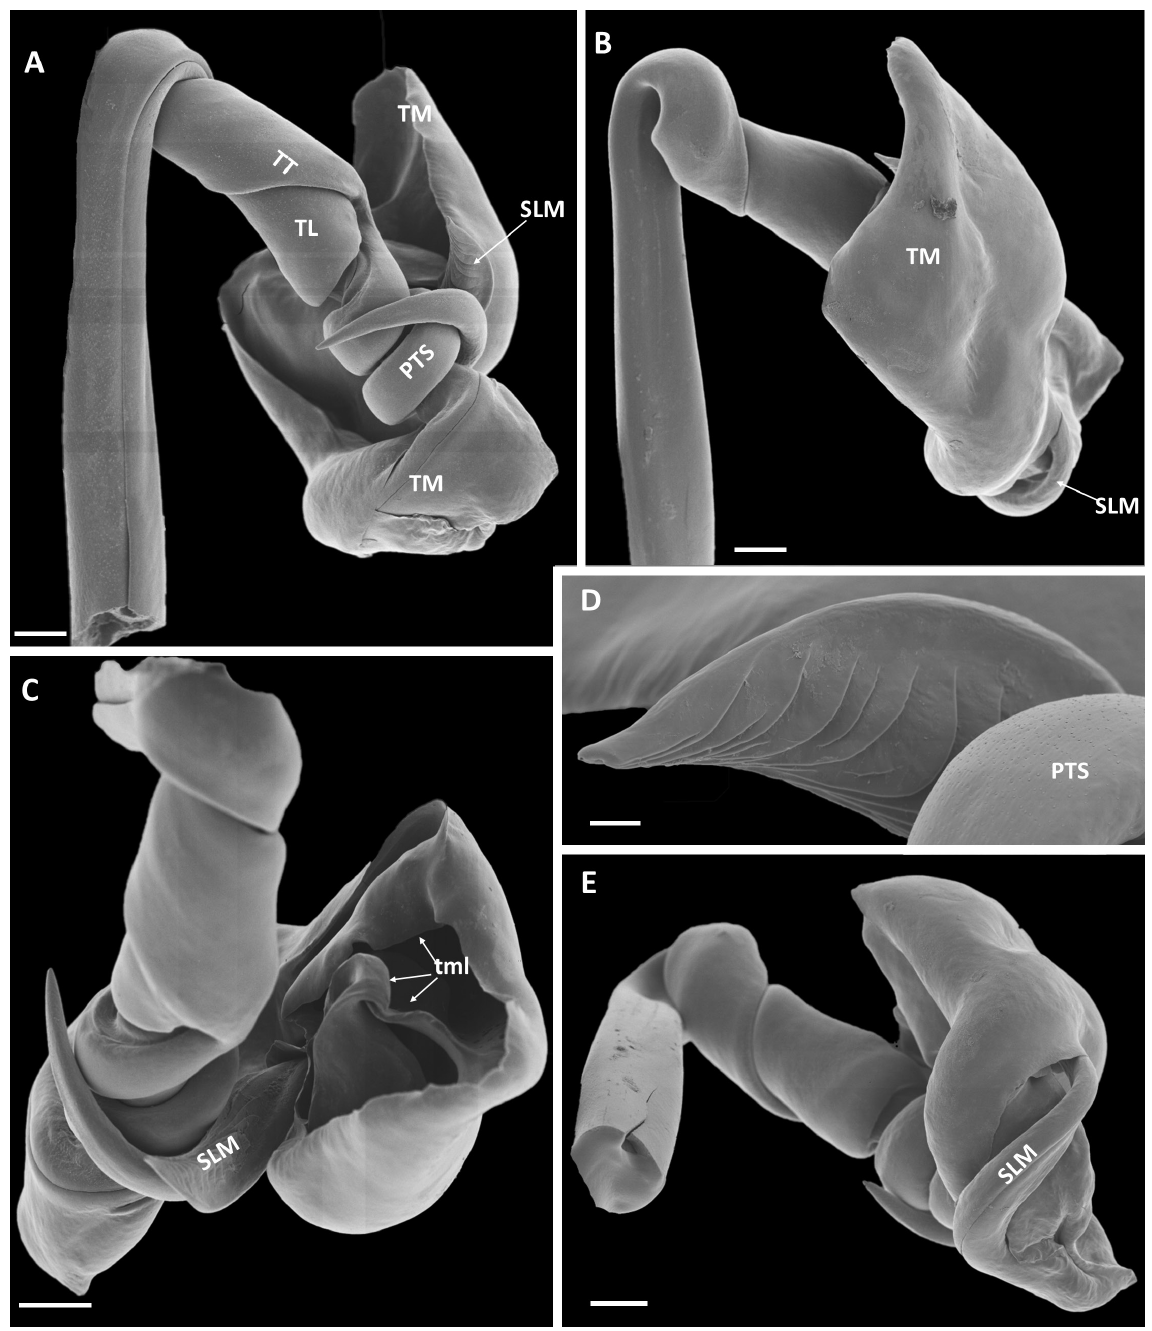
Fig. 53. Raduliverpa donatellae sp. nov., holotype, ♂ (NHMD 621759), gonopod telopodites. A . Right telopodite, posterior view. B . Left telopodite, subanterior view. C . Right telopodite, disto-mesal-basal view. D . Close-up of right solenomere tip (also with part of post-torsal spine) to show the genus- characteristic striation. E . Left telopodite, anterior-basal view. Abbreviations: PTS = post-torsal spine; SLM = solenomere; TL = torsotope lobe; TM = telomere; tlm = telomere lamellae; TT = torsotope. Scale bars: A–C, E = 0.1 mm; D = 0.02